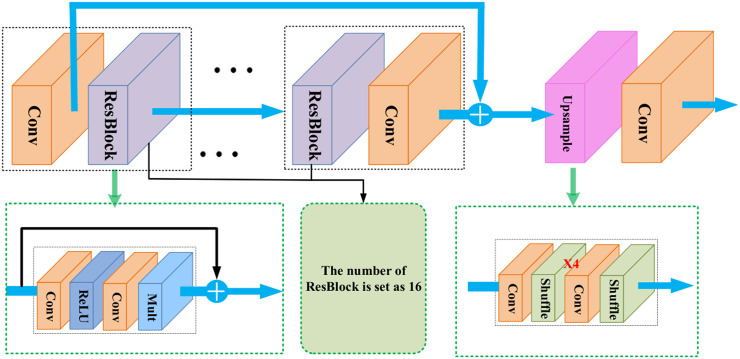
Architecture of the SR net, the network consists of 16 residual blocks and 64 filters, which ensure that multi-level features can be shared to boost the performance.